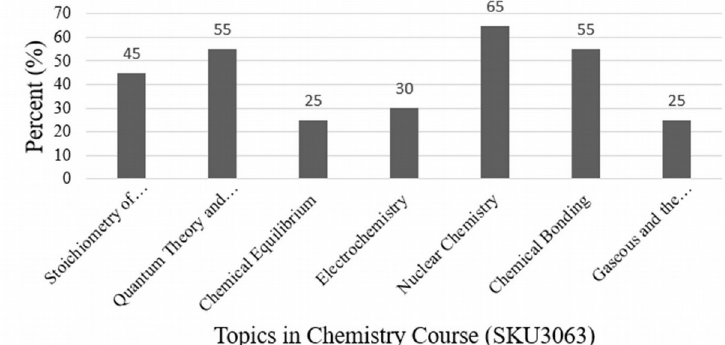
Figure 3. Percentage of topic selection in Chemistry Course (SKU3063) among the lecturers (Hamid, 2020)